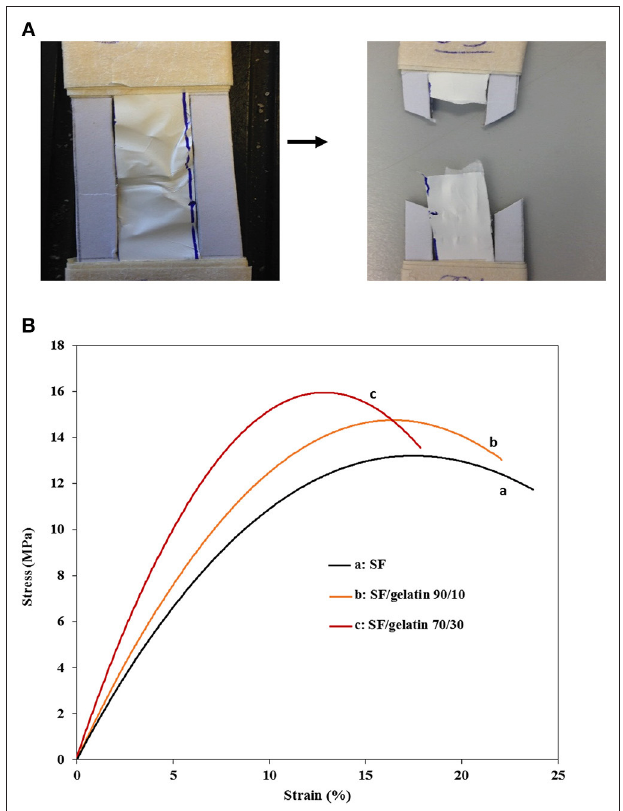
FIGURE 8 | (A) A representative testing sample before and after tensile failure, (B) Typical stress-strain curves of GTA crosslinked SF nanofiber mats and SF/gelatin nanofiber mats.